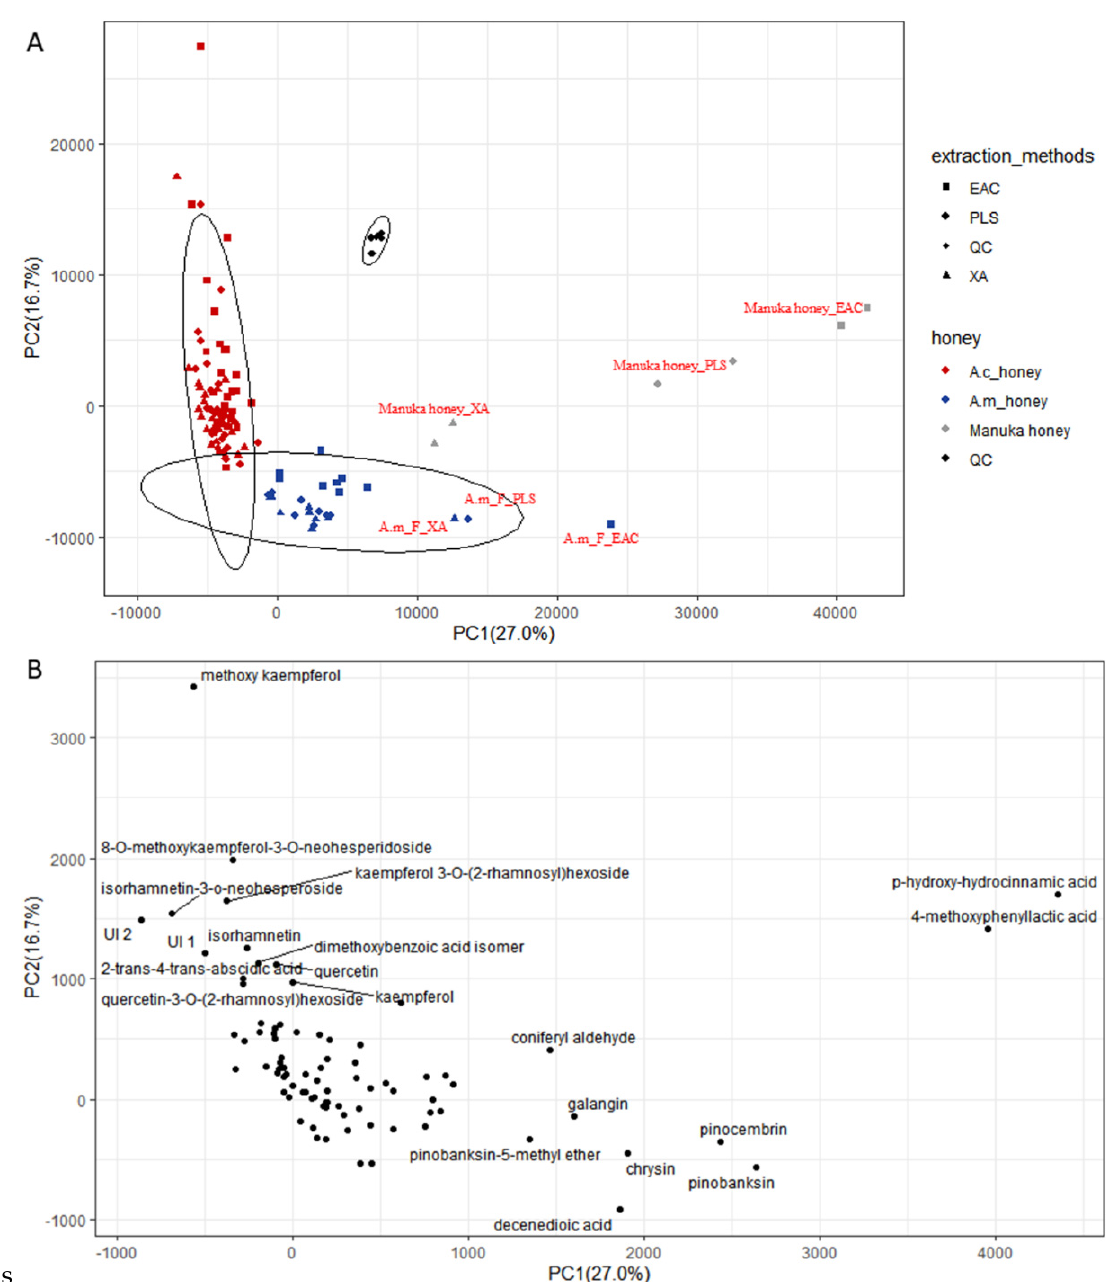
Figure 1. Principal components analysis (PCA) of A. cerana and A. mellifera honeys. Results of PCA of honeys: scores plot ( A ) and loadings plot ( B ).